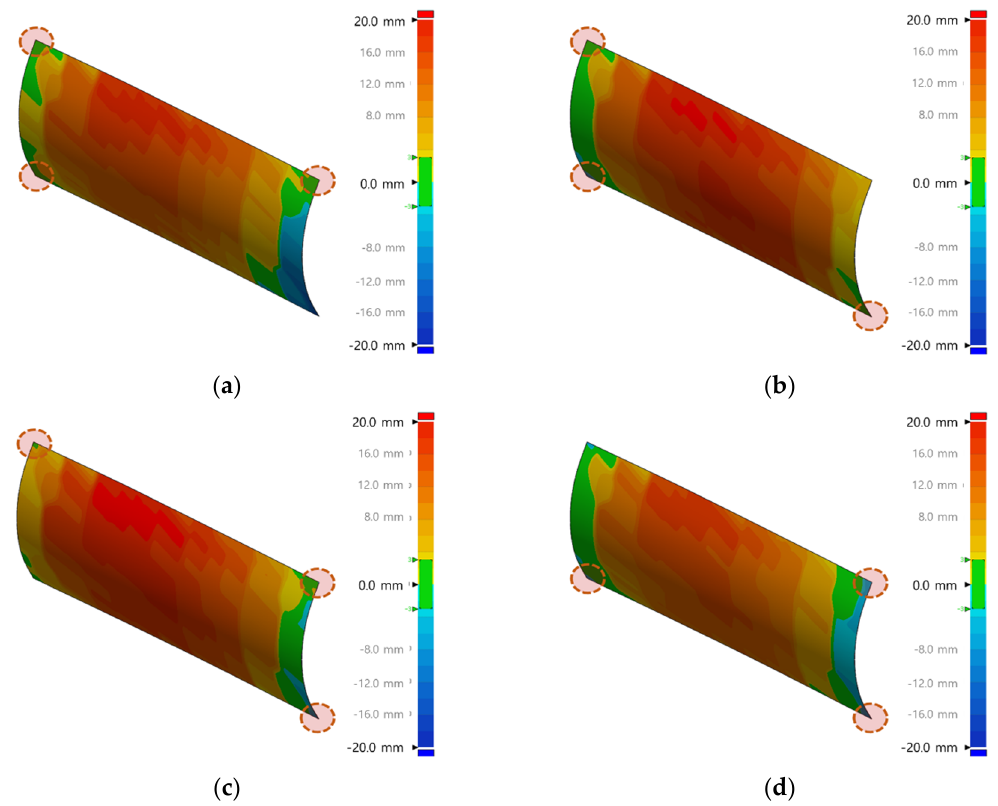
Figure 12. Comparisons of experimental result and predictive result with different reference points. ( a ) Case 2; ( b ) Case 3; ( c ) Case 4; ( d ) Case 5. Table 2. Comparison of errors between the design curved shape and the shape after simulation.